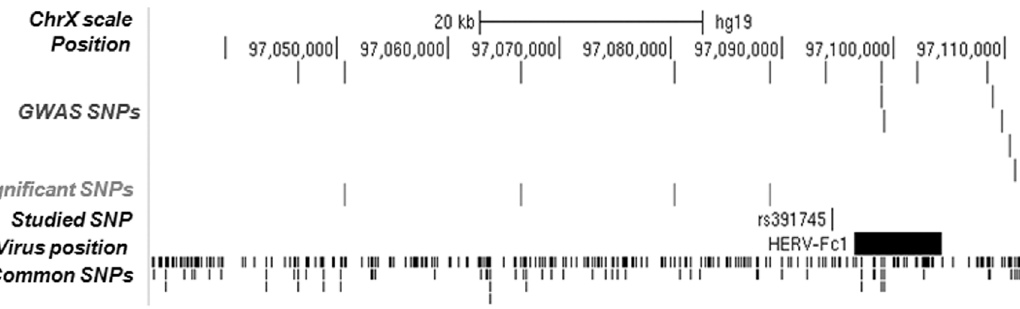
Figure 3. Scheme of the HERV-Fc1 position and polymorphisms in the locus. The figure depicts from top to bottom: Chr X scale; chromosomal position as indicated in B37/gh19 (Position); SNPs genotyped in the IMSGC-WTCCC2 GWAS (GWAS SNPs); statistically significant SNPs with p # 0.05 (Significant SNPs); position of rs391745 (Studied SNP); HERV-Fc1 retrovirus copy position (Virus Position) and common polymorphisms mapping at this locus (Common